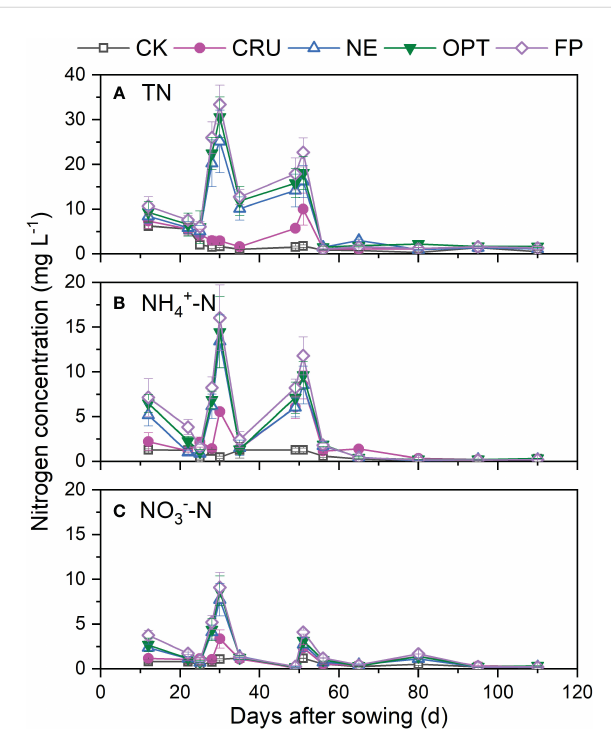
FIGURE 1 Dynamics of (A) TN, (B) NH 4+ -N, and (C) NO 3 – N concentration of the surface water in paddy fi elds under different nitrogen treatments. The vertical bars mean standard deviations of the means CK, zero nitrogen application; CRU, controlled-release urea application; NE, nitrogen expert-based fertilization application strategy; OPT, optimized nitrogen fertilizer application strategy recommended by local government; FP, farmer's experience-based nitrogen fertilizer application